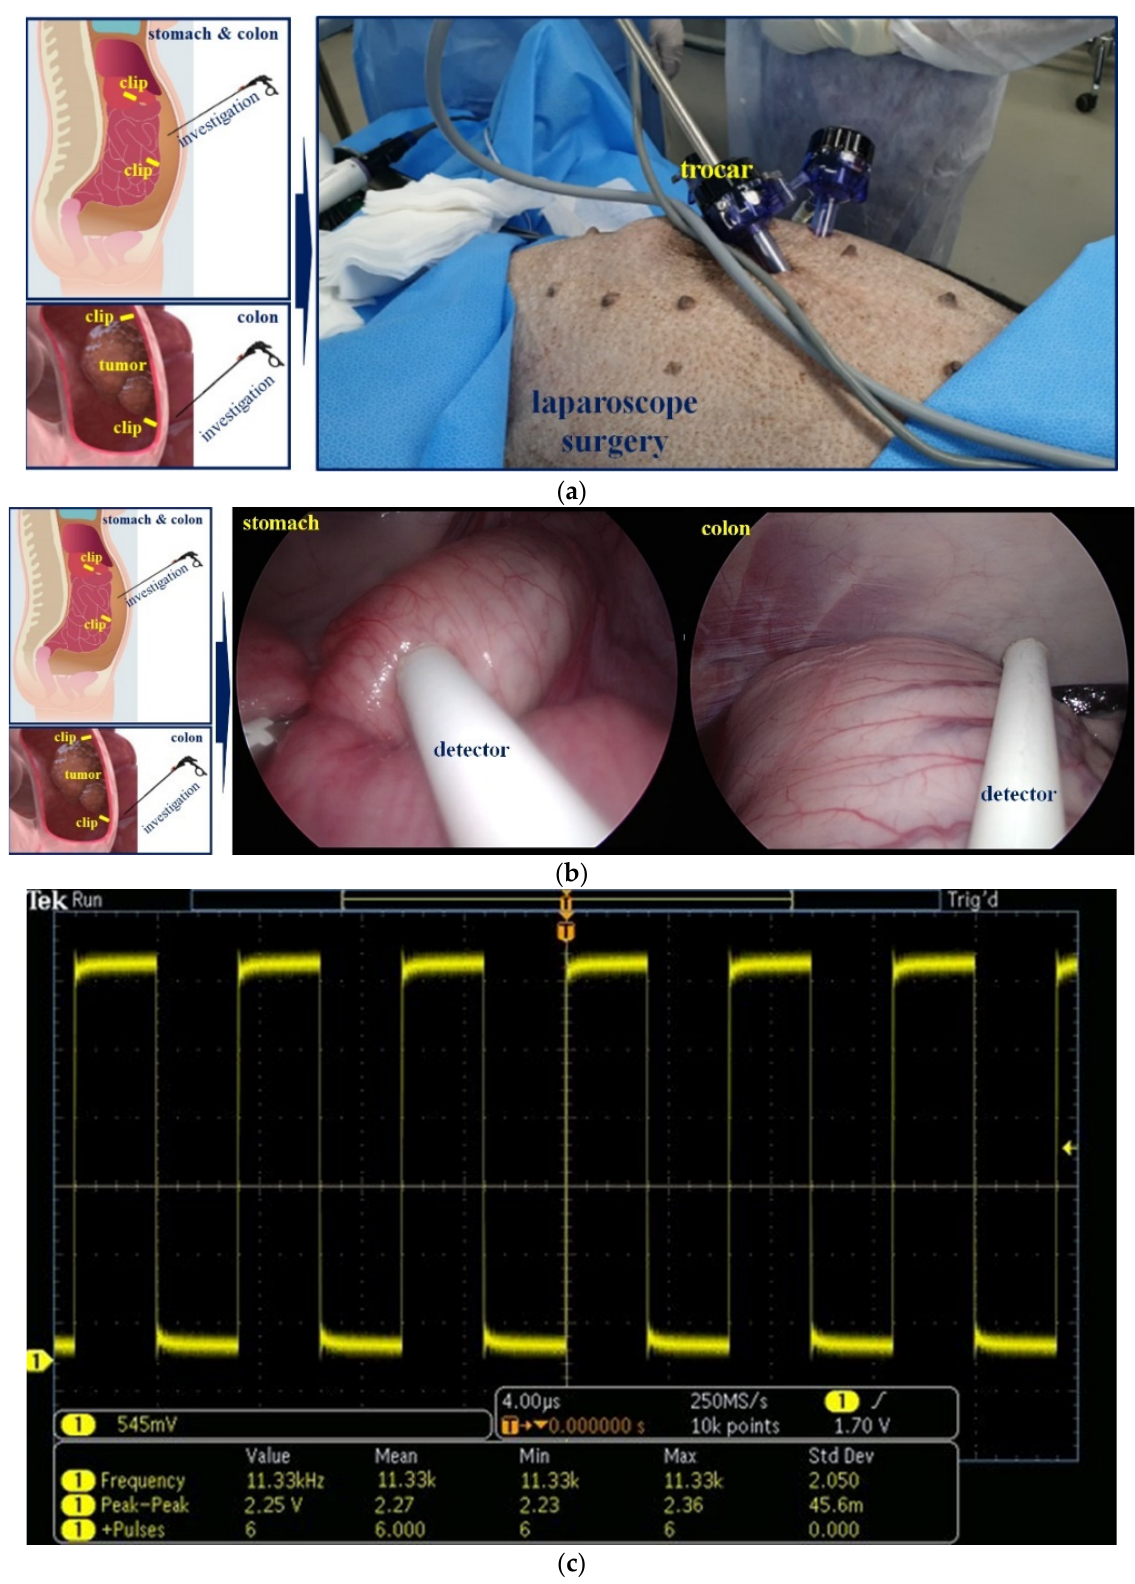
Figure 15. Animal test of the developed clip-detector: ( a ) laparoscope surgery ( b ) clip detection ( c ) clip detected signal.